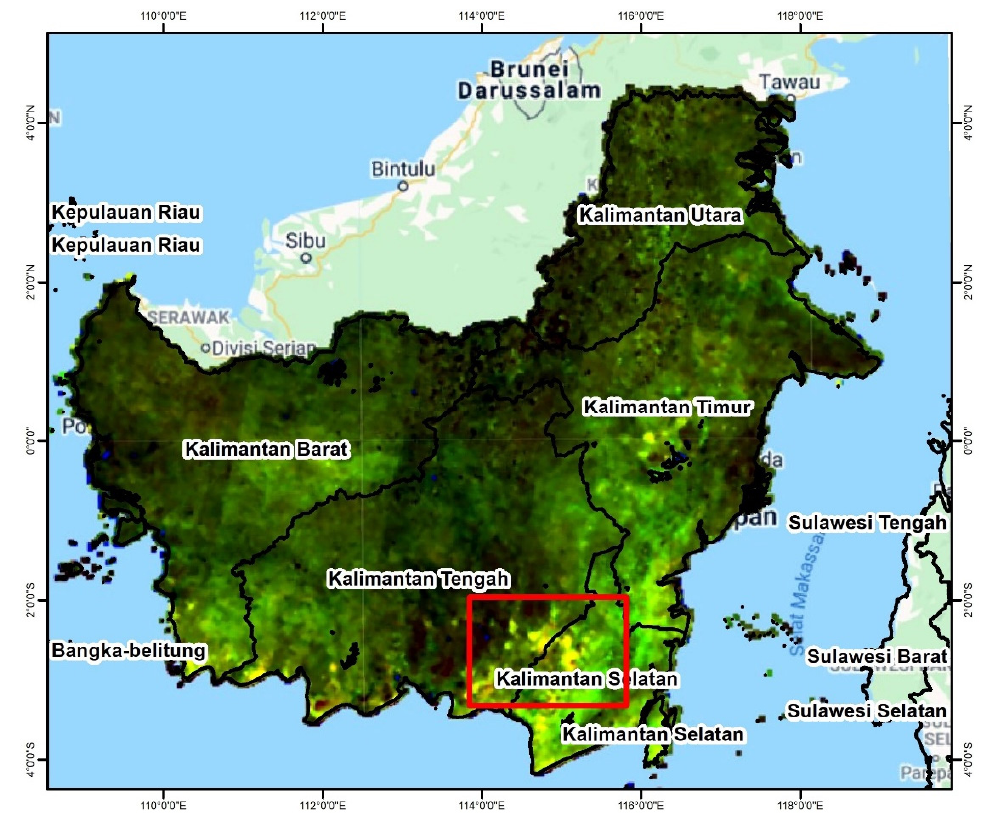
Figure 8. Composite RGB (RBR_VH, RBR_VV, and RBD_VV) with the AoI marked in the red rectangle, where a bright color indicates the burnt areas.